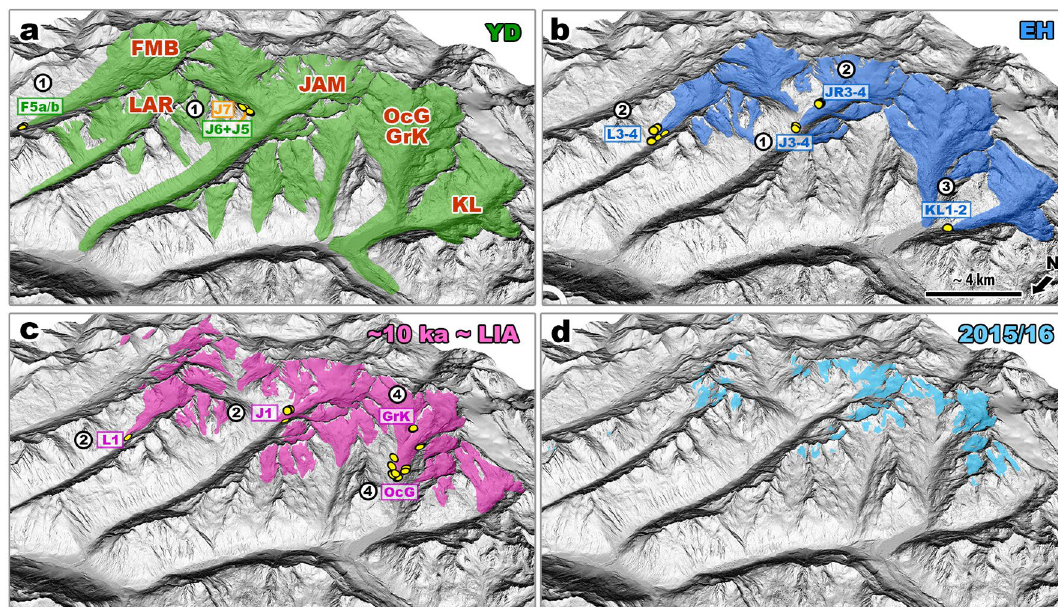
Figure 8. Possible extents of Silvretta glaciers during the (a) the later YD, (b) the EH, (c) around 10 ka and during the LIA, and (d) in 2015/16 CE. Positions of dated boulders are indicated with yellow symbols across all valleys and time slices and are published in this study (#1), in Braumann, et al. 9 (#2), in Moran, et al. 18 (#3), and in Braumann, et al. 19 (#4). IDs of corresponding moraines are adopted from original publications and are shown in rectangles. Ice margins positions with geochronological data available (yellow circles) are reliable. All other ice margins in ( a ) and ( b ) are estimates and are based on Hertl 80 . LIA and modern ice margins are taken from the Austrian and the Swiss glacier inventories, respectively 15,16 . The Jamtal moraine record in conjunction with previously published moraine records of the region indicates that the transition from YD to EH ice extents occurred within a few centuries. DEMs provided by Land Tirol (www. tirol. gv. at/ als; CC BY 4.0) and